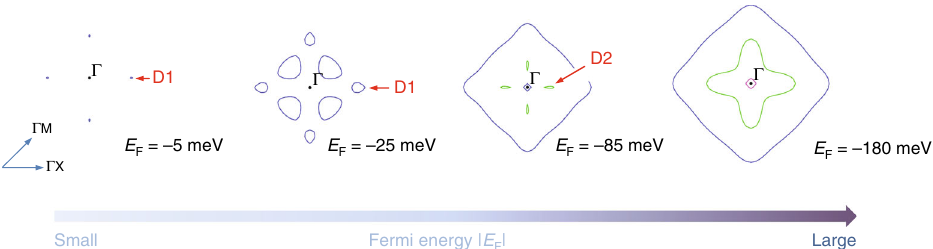
Fig. 5 Evolution of Fermi surface in Sr 3 SnO with E F obtained by fi rst-principles calculation. Two different Dirac nodes D1 and D2 appear successively in Sr 3 SnO.